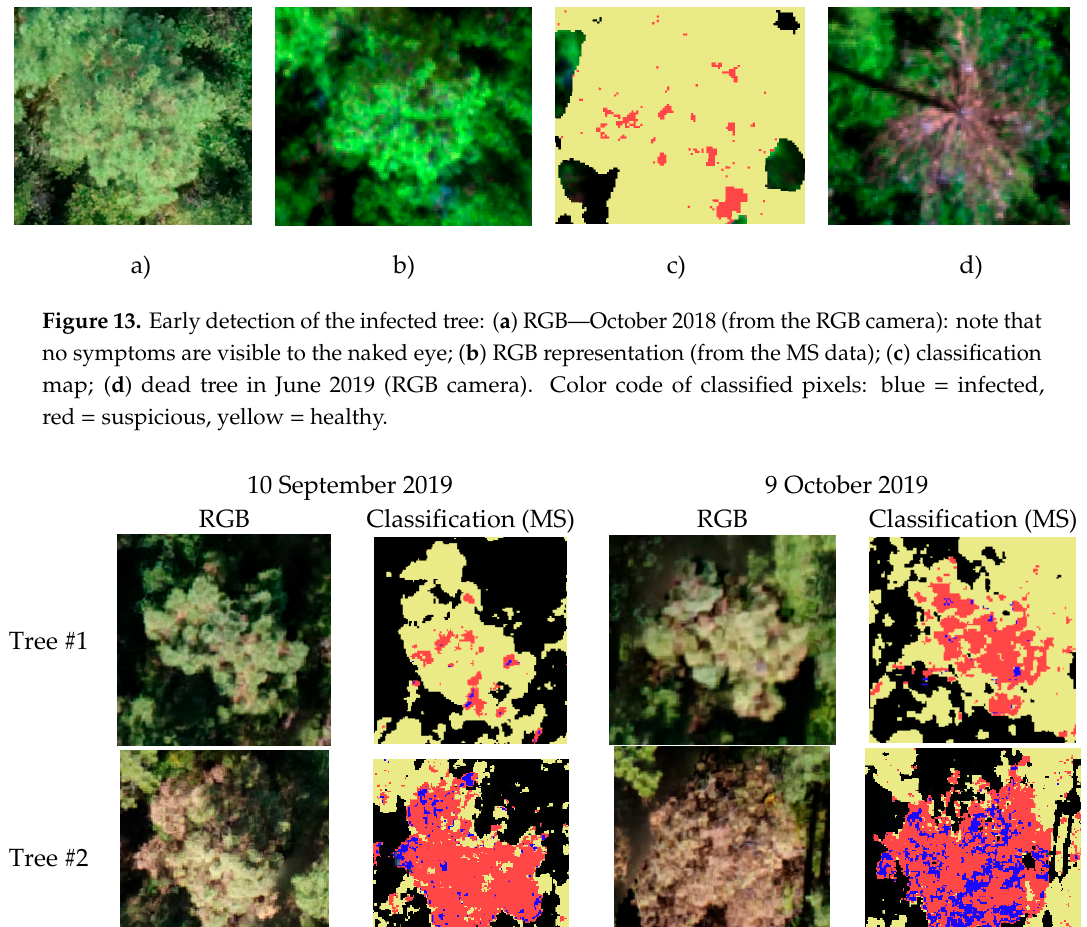
Figure 13. Early detection of the infected tree: a ) RGB—October 2018 (from the RGB camera): note that no symptoms are visible to the naked eye; b ) RGB representation (from the MS data); c ) classification map; d ) dead tree in June 2019 (RGB camera). Color code of classified pixels: blue = infected, red = suspicious, yellow = healthy.